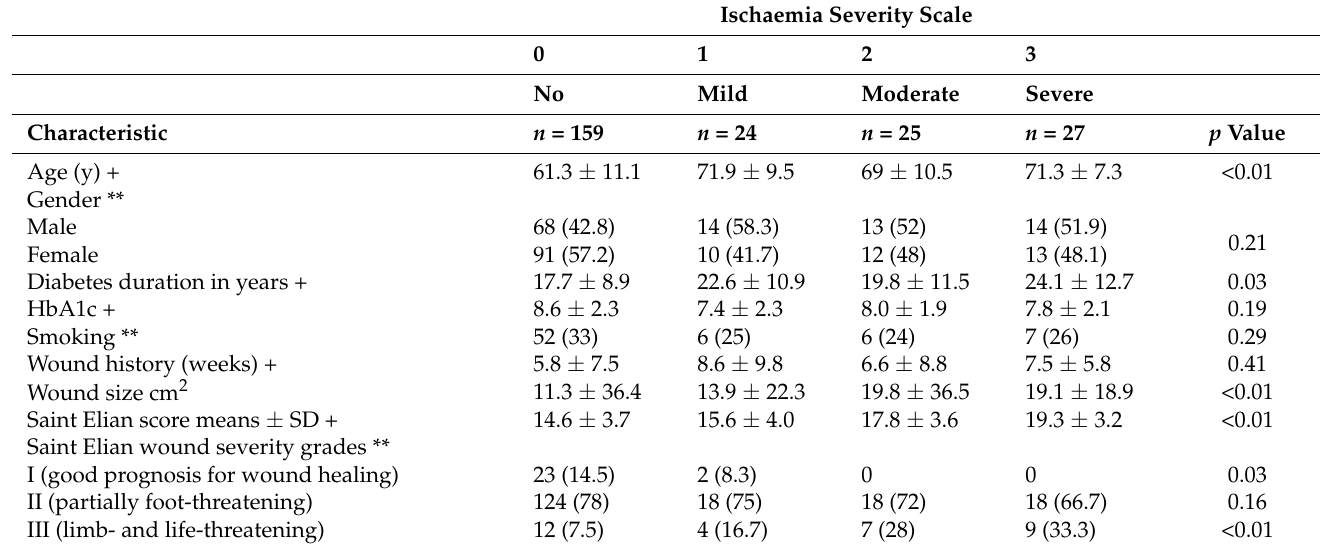
Table 1. Baseline demographic, clinical, and wound